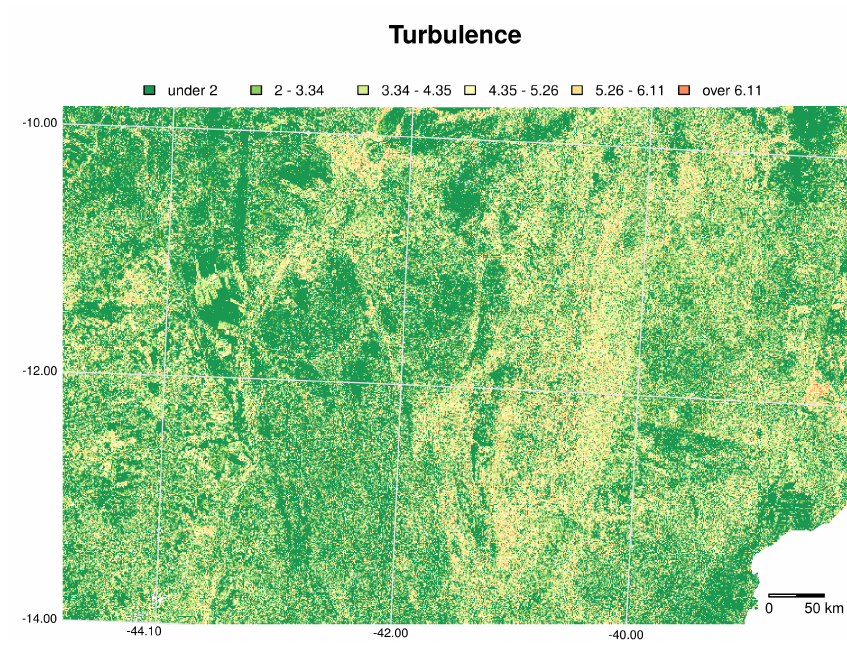
Figure 6. Entropy and turbulence index.